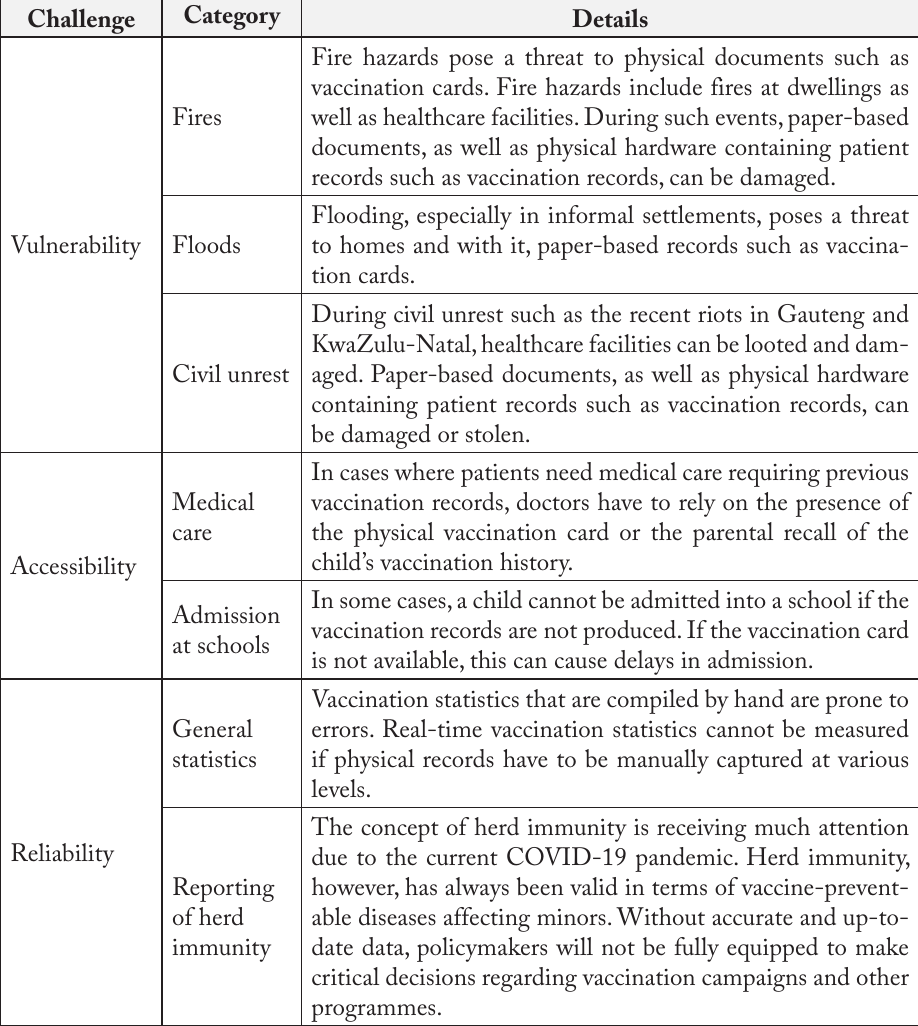
Table 1: Challenges with paper-based vaccination cards